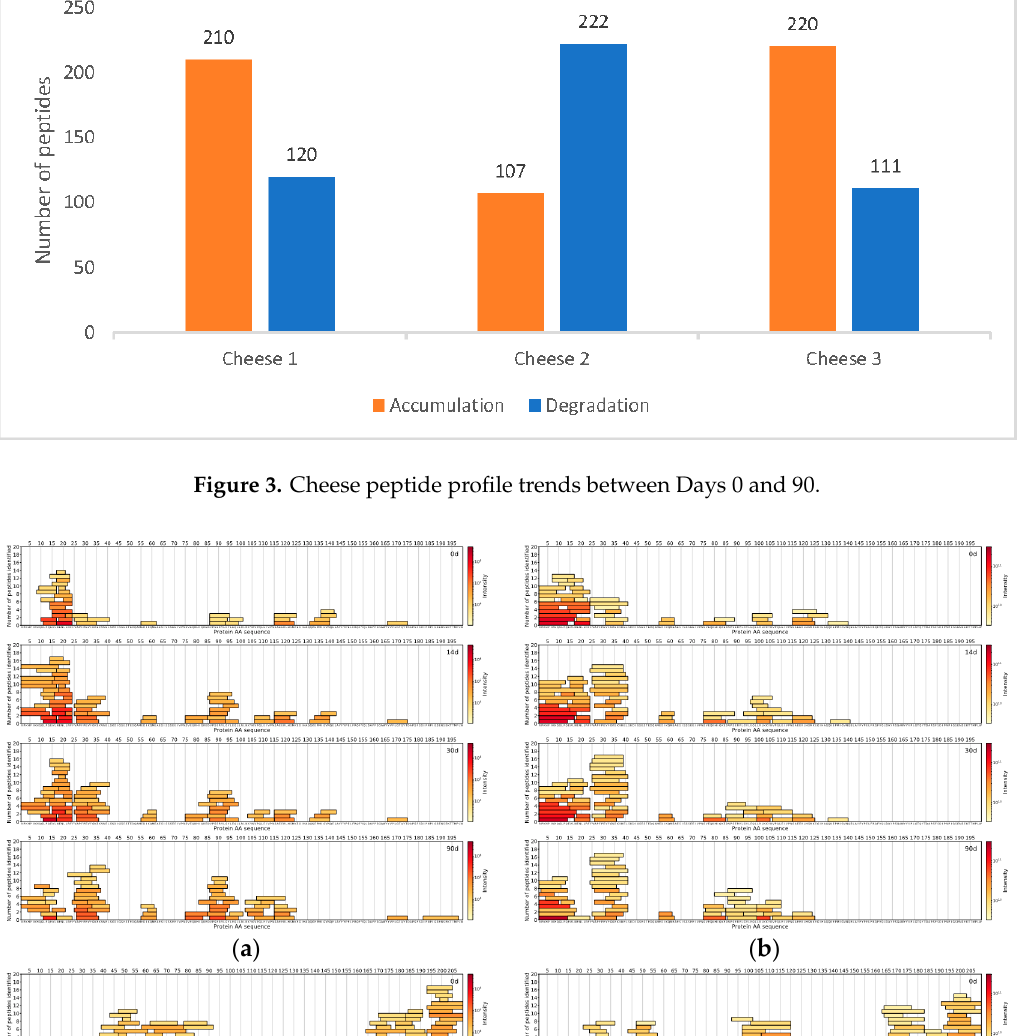
Figure 3. Cheese peptide profile trends between Days 0 and 90.